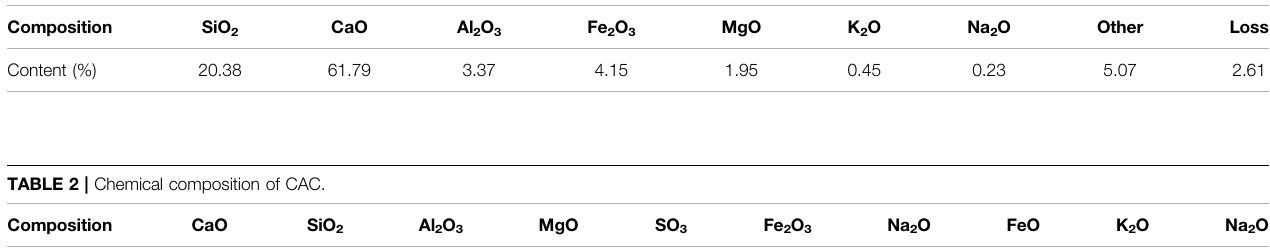
TABLE 1 | Chemical composition of Class G oil well cement.